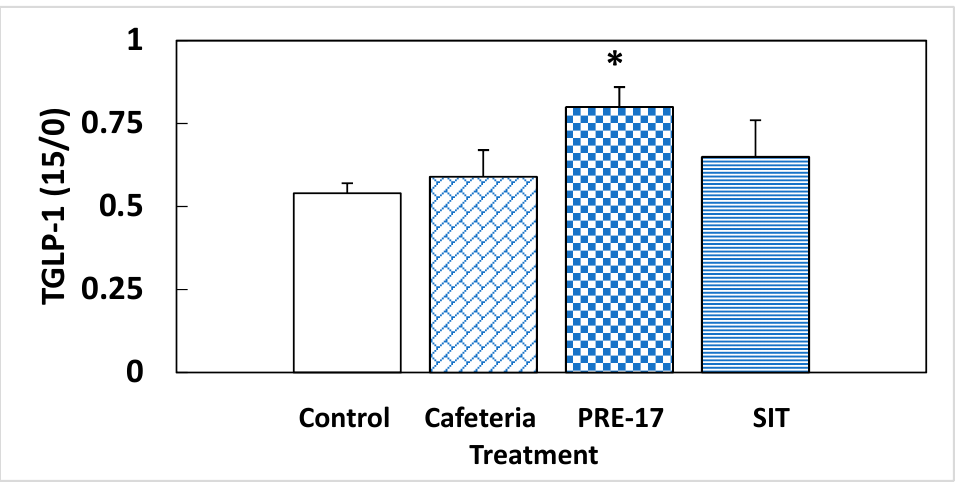
Figure 2. Relative total GLP-1 secretion in a fasting situation. Rats were treated with 0.5 g/Kg BW for the first 10 days, and then they were put on a cafeteria diet for 14 weeks (PRE-17), or a GSPE dose was administered, simultaneously with the cafeteria diet, every second week (SIT). After o/n fasting, a tail blood sample was obtained at time 0 and 15 min after an oral glucose load (2 g/kg BW). At both times, the total GLP-1 was measured, and their ratio was calculated. The data are the mean ± standard error (S.E.M.) ( n = 7). Statistical differences identified by Student’s t -test are defined by * when p < 0.05 between treatments.